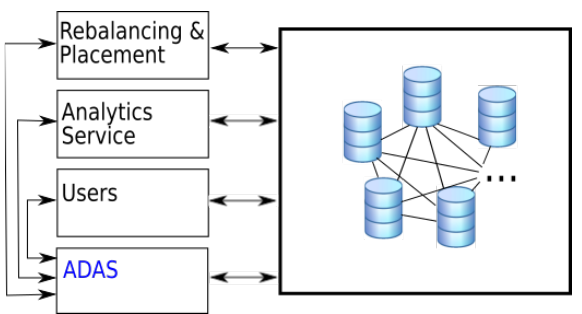
Figure 1. The learning agent ADAS plays an auxiliary role in delivering better data allocation and proposing information on